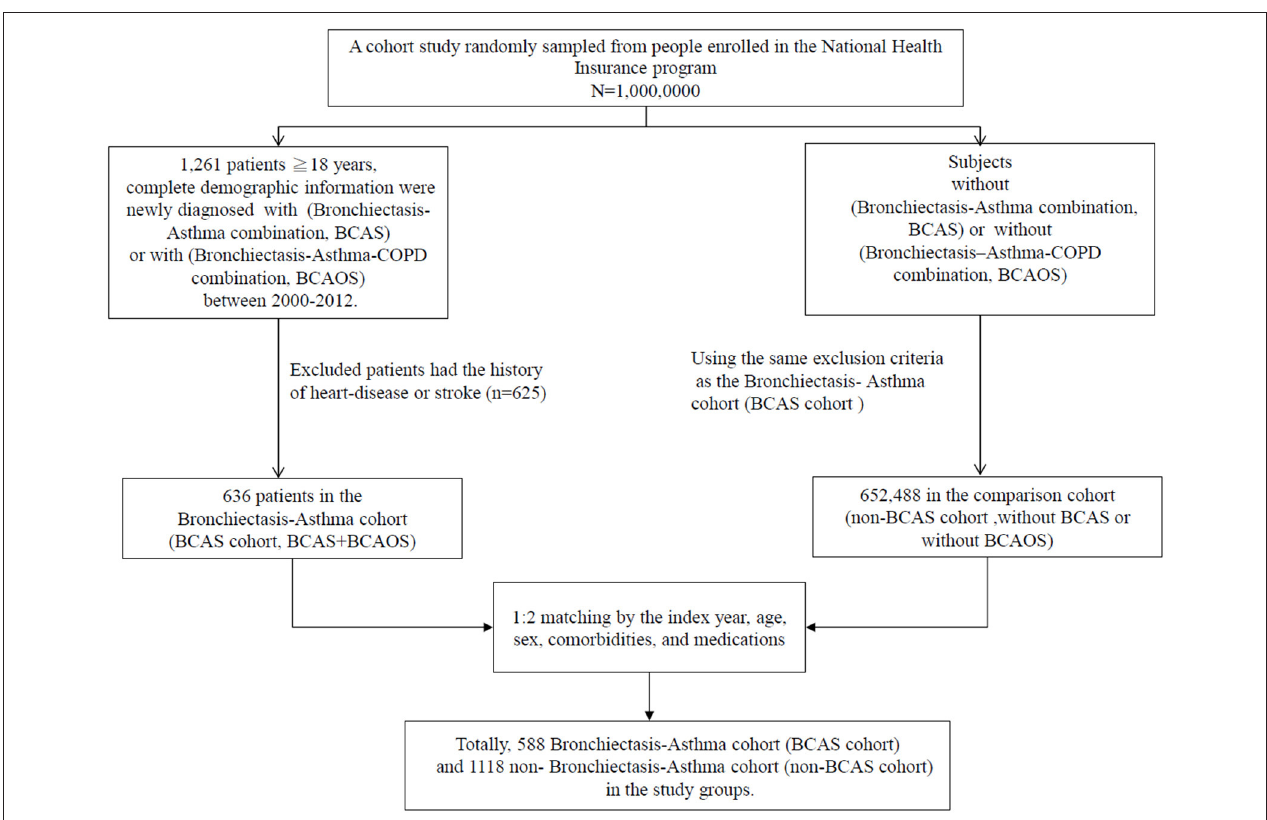
FIGURE 1 | Flow chart of the selection of